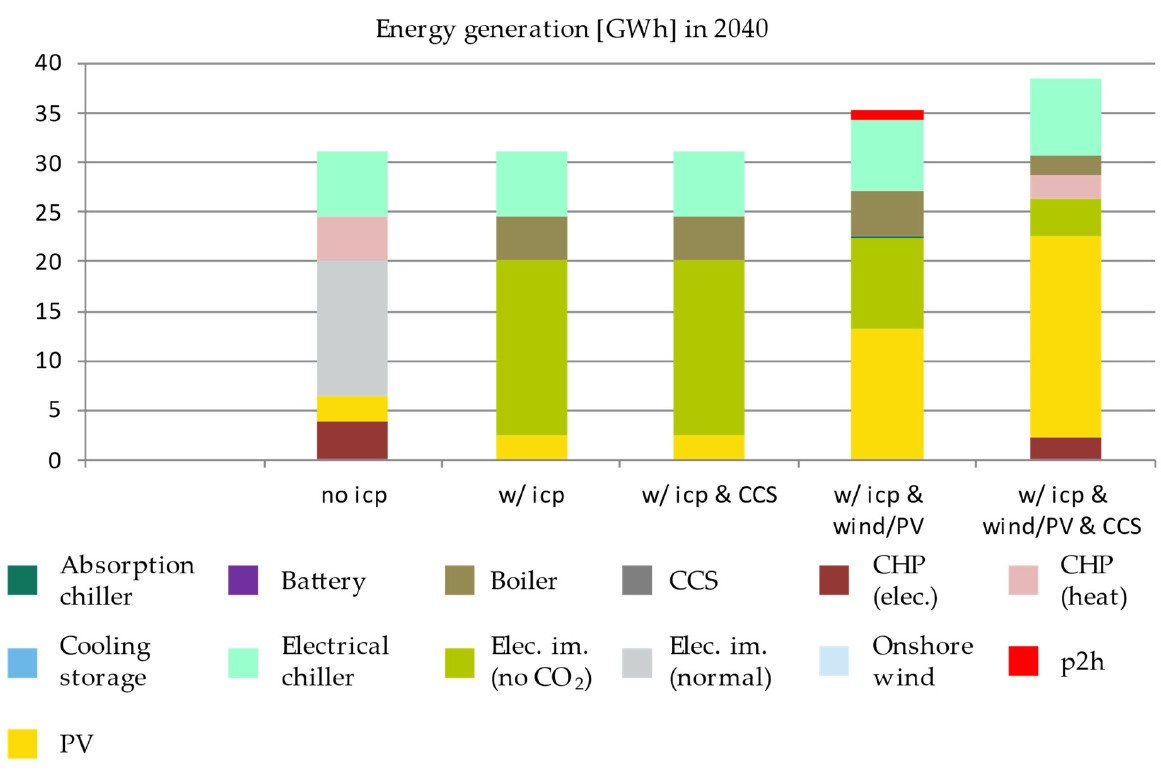
Figure 6. Energy generation for the Japanese scenarios in 2040.